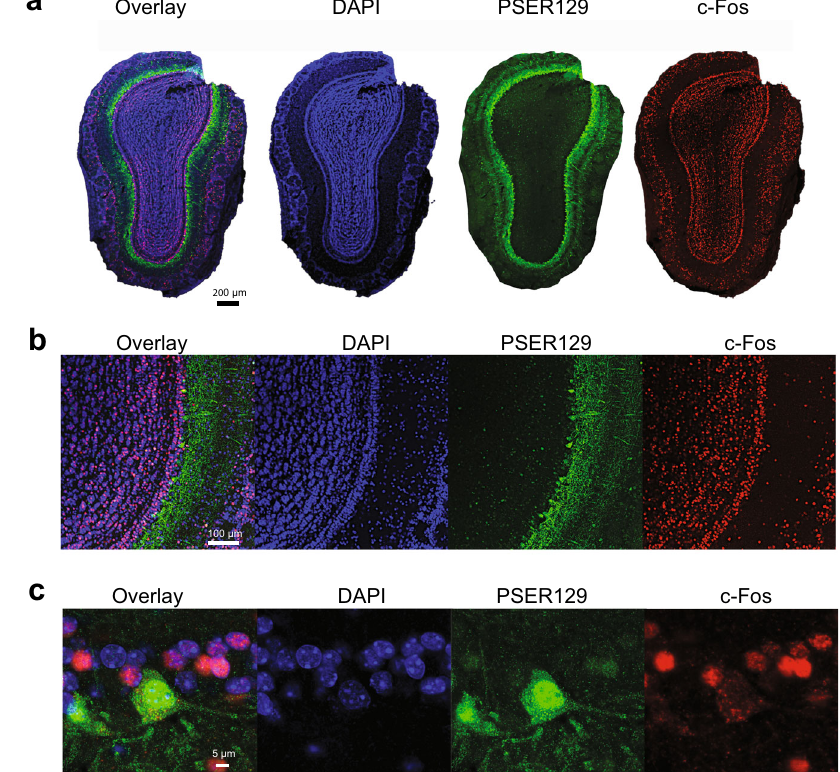
Fig. 8 PSER129 positive mitral cells are c-Fos negative. The OB from WT mice were labeled for PSER129 and neuronal activity marker c-Fos. a Whole section of confocal scans of labeled OB. b High-magni fi cation confocal images of the mitral cell layer. c Expanded high-magni fi cation images of a single PSER129 positive mitral cell. (WT mice, n =